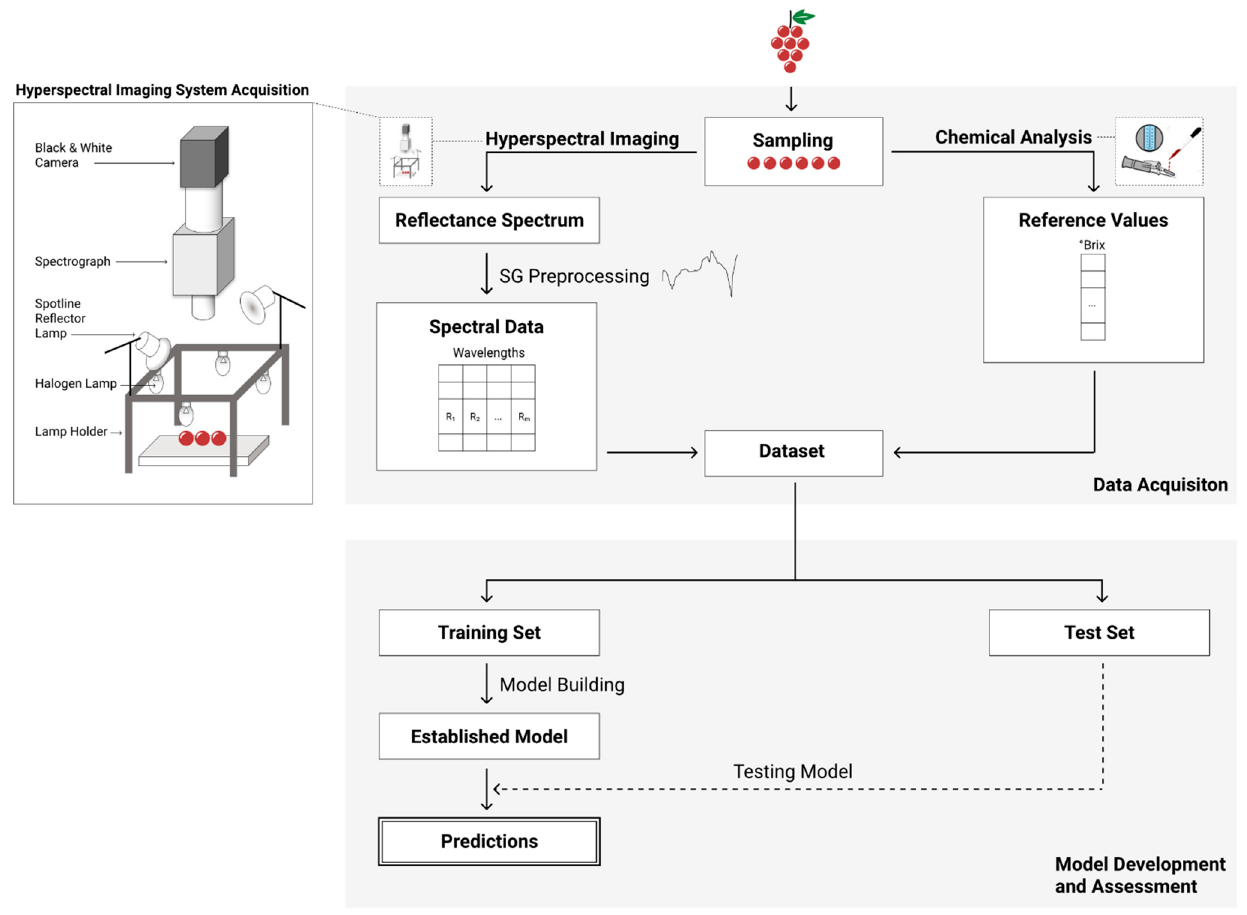
Figure 1. Graphical representation of the experimental procedure adopted in the current work.